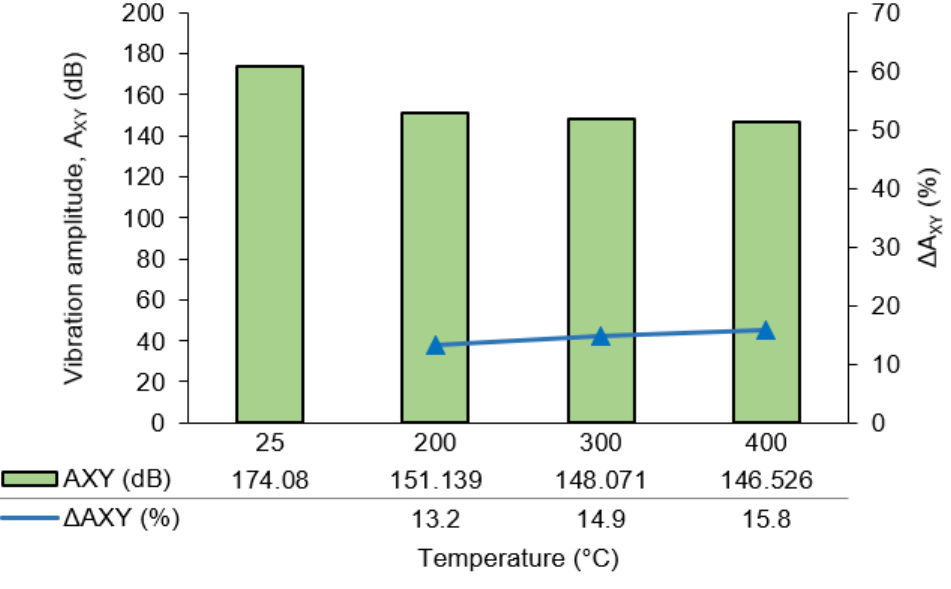
Figure 12. Vibration amplitude and vibration amplitude reduction during machining at various temperature conditions.